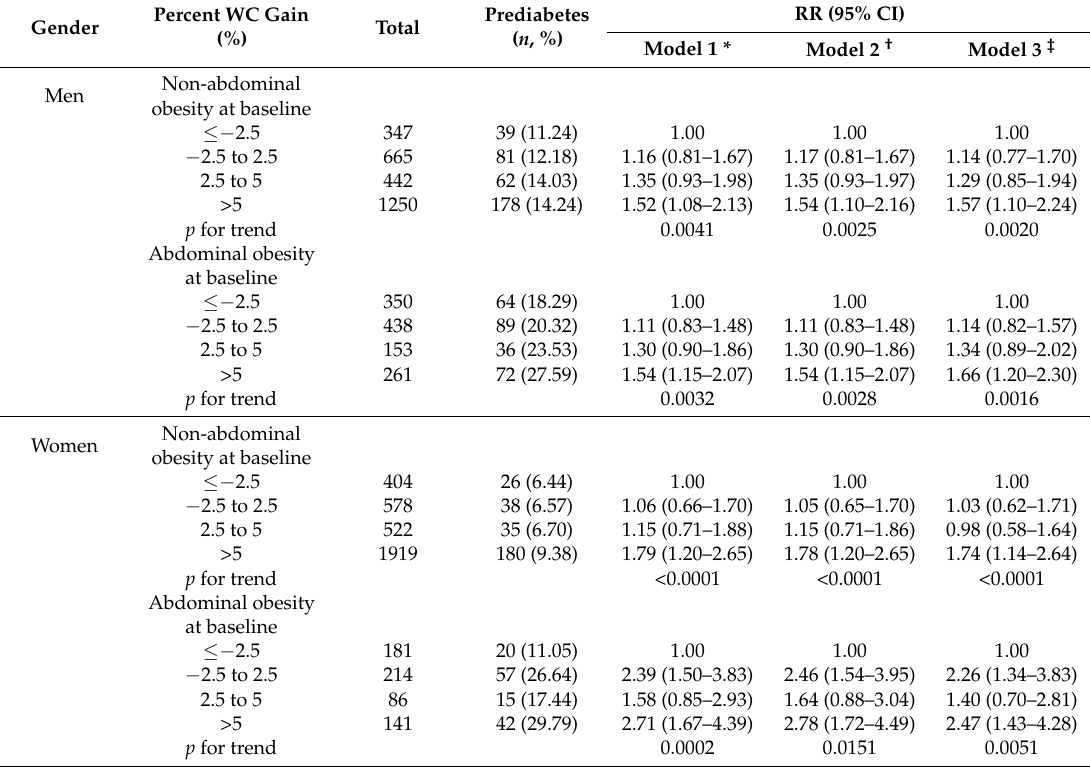
Table 2. Risk of prediabetes by percent WC